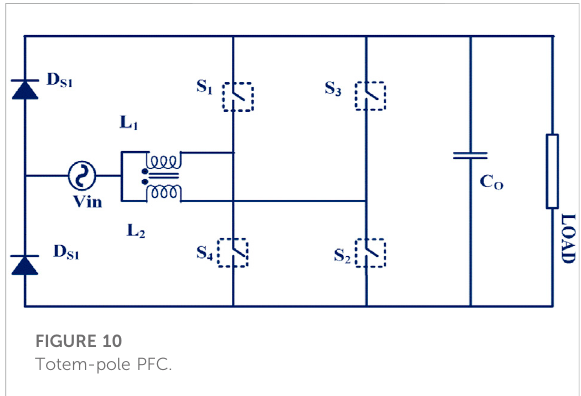
FIGURE 10 Totem-pole